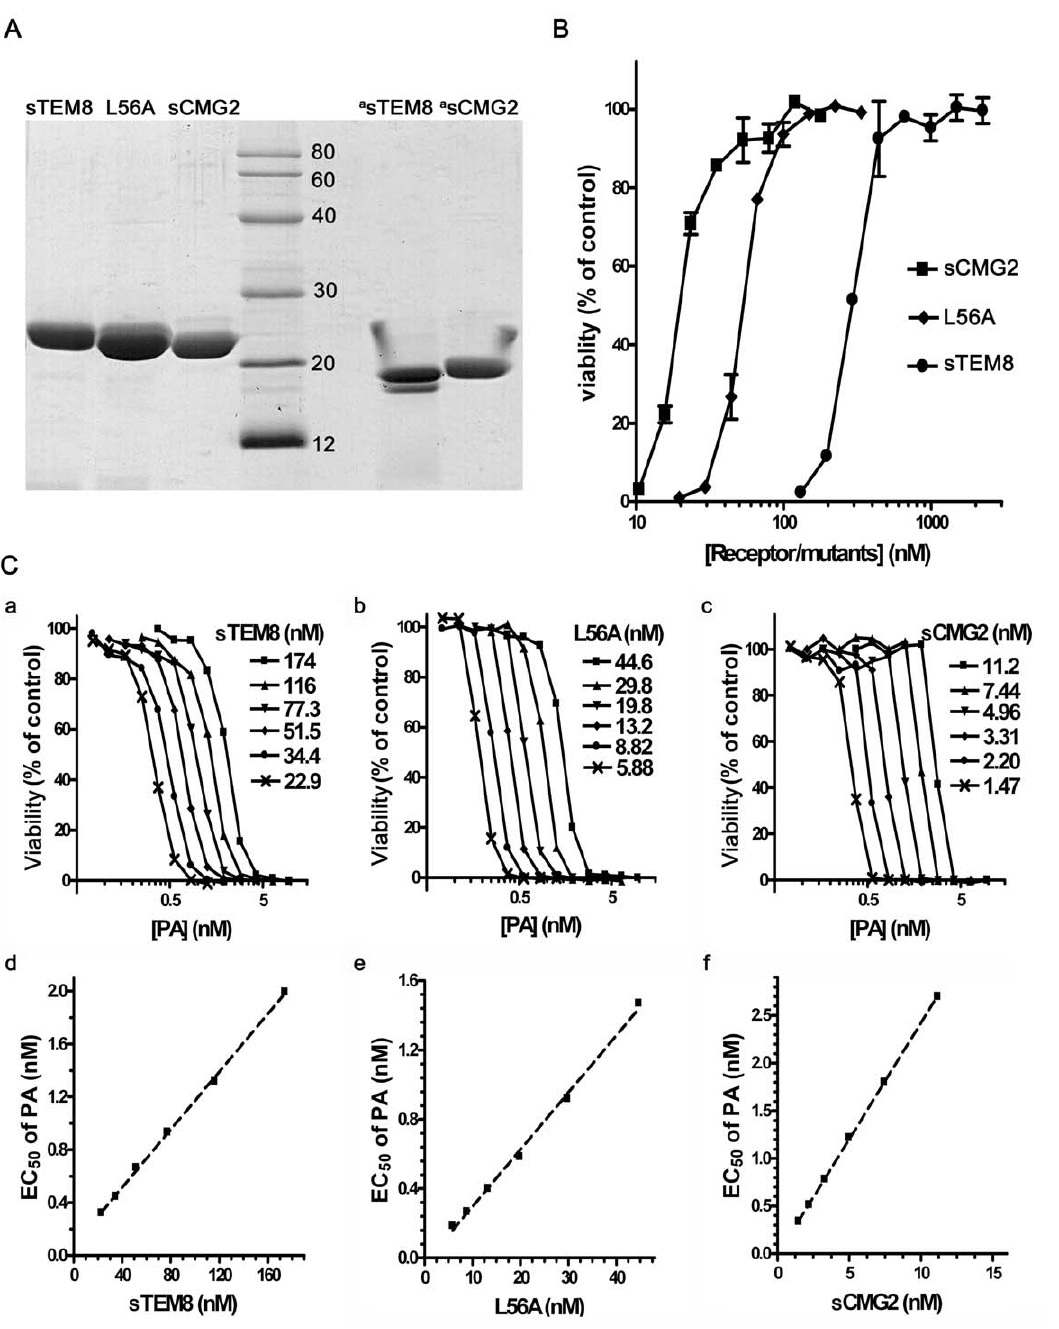
Figure 1. Receptor variants can protect J774A.1 cells from LeTx intoxication. A . vWA domains of anthrax toxin receptors/variants were fused with N-terminal His tags, purified by Ni affinity chromatography and anion exchange chromatography and analyzed with SDS-PAGE. B . The results for cell protection assays. Viability was assessed as described in the methods section. Each assay was performed at least three times, with duplicates within each assay. Data points represent the mean 6 SEM in duplicate for one representative experiment. C . The results for the Schild plot assays; a, b, and c. PA dose-dependent survival curves for cells at a fixed receptor/mutant concentration; d, e, and f. These graphs were obtained by plotting the EC 50 values corresponding to different receptor concentrations, fixed by linear regression using GraphPad Prism software. Each assay was performed at least three times. The data shown are for one representative experiment. a Samples were not mixed with 2-mercaptoethanol.